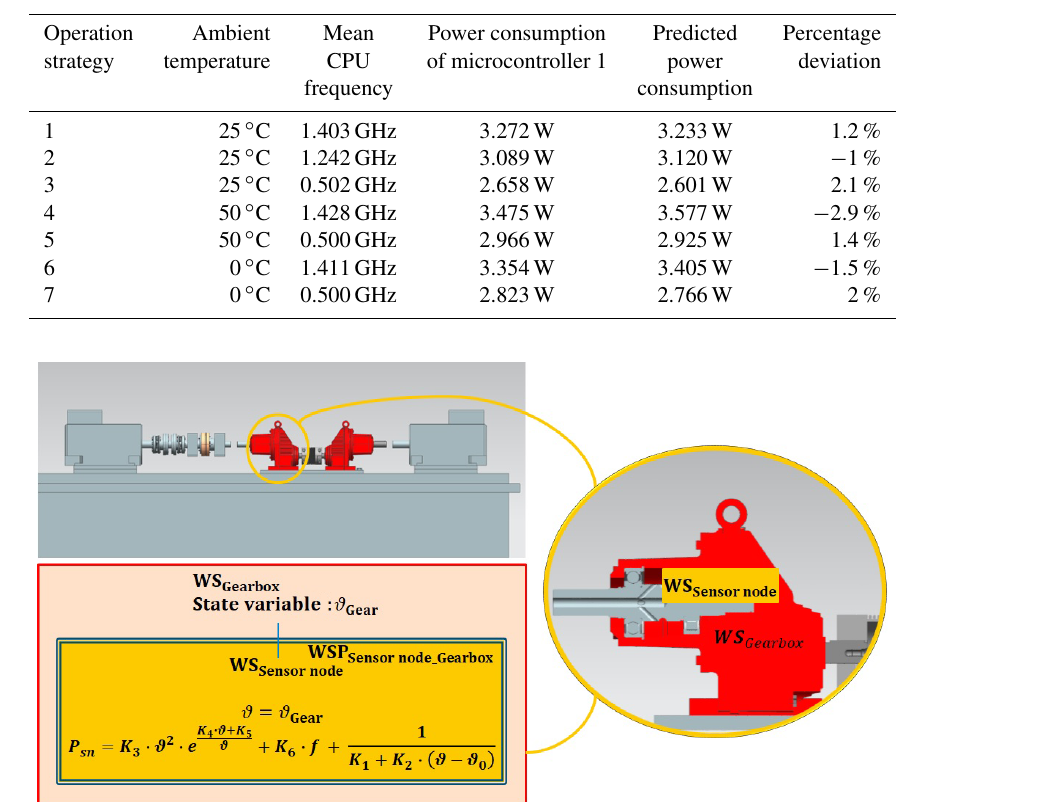
Table 2. Overview of the measured and calculates energy consumption.